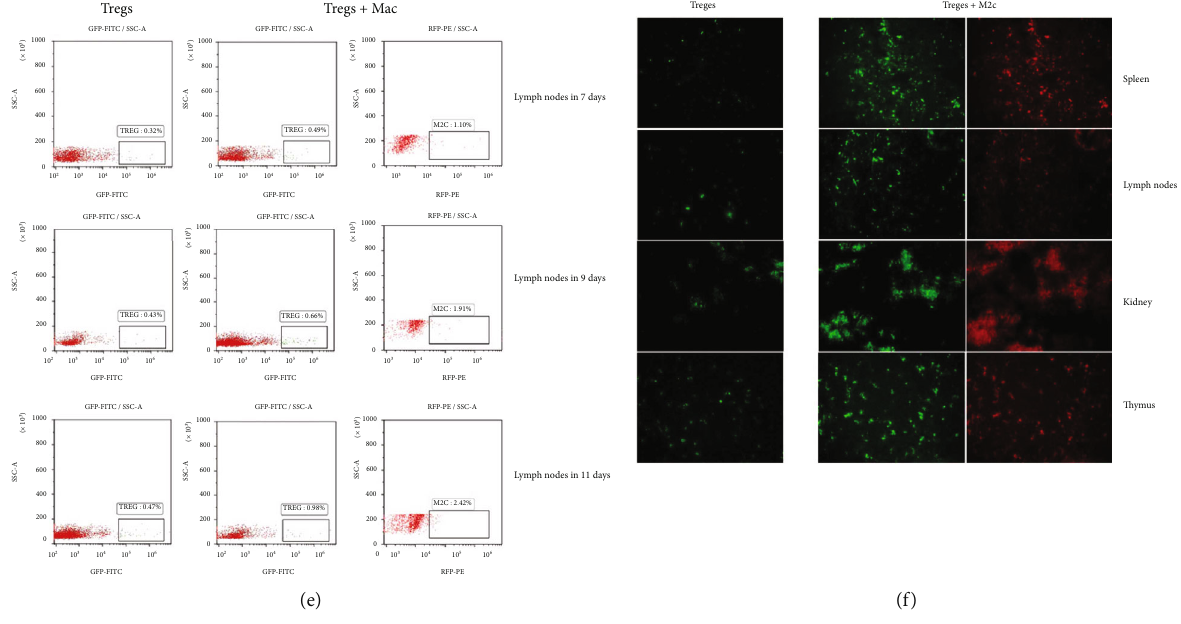
Figure 2: M2c macrophages promote the migration of Tregs from the blood to di ff erent sites. (a – e) Flow cytometry of Tregs in the blood, spleen, thymus, kidney, and renal draining lymph nodes in animals treated with Tregs or M2c macrophages+Tregs. (f) Immuno fl uorescence micrographs of Tregs in the blood, spleen, thymus, kidney, and renal draining lymph nodes in animals treated with Tregs or M2c macrophages+Tregs. FITC: fl uorescein; GFP: green fl uorescent protein; qRT-PCR: quantitative reverse transcription-polymerase chain reaction; RFP: red fl uorescent